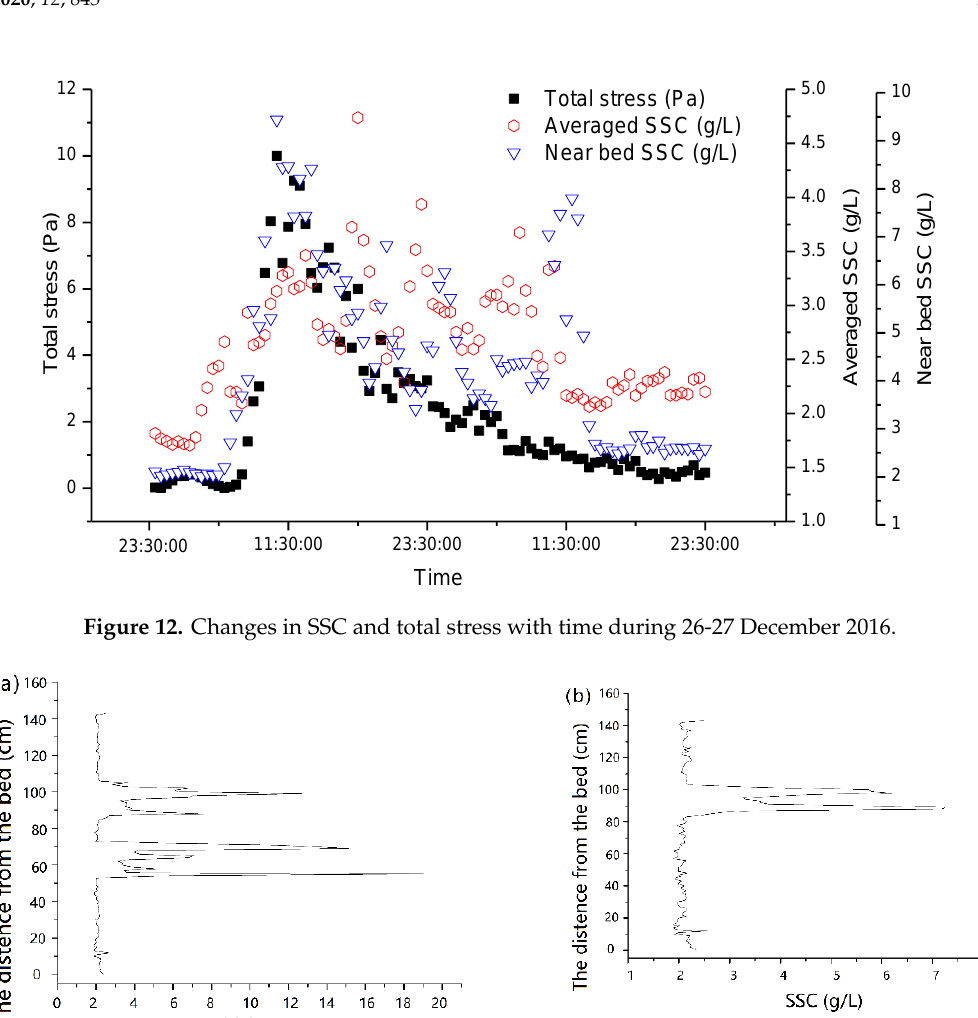
Figure 11. The average SSC under significant wave height below 1.25 m condition is not lower than the SSC when the significant wave height exceeds 1.5 m.